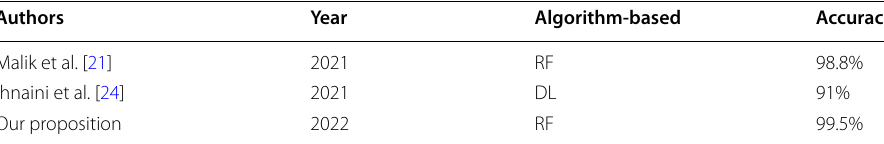
Table 5 Summary of the different algorithms on Dataset2